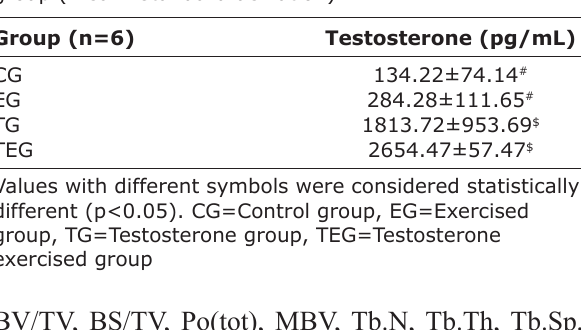
Table-1: Testosterone serum levels in each experimental group (mean±standard